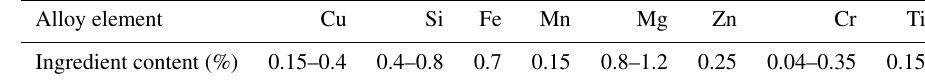
Table 1. Main alloying elements and composition content of aluminum alloy 6061.